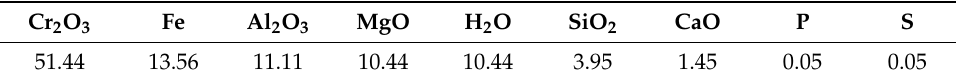
Table 1. Brief chemical components of chromite concentrate (wt.